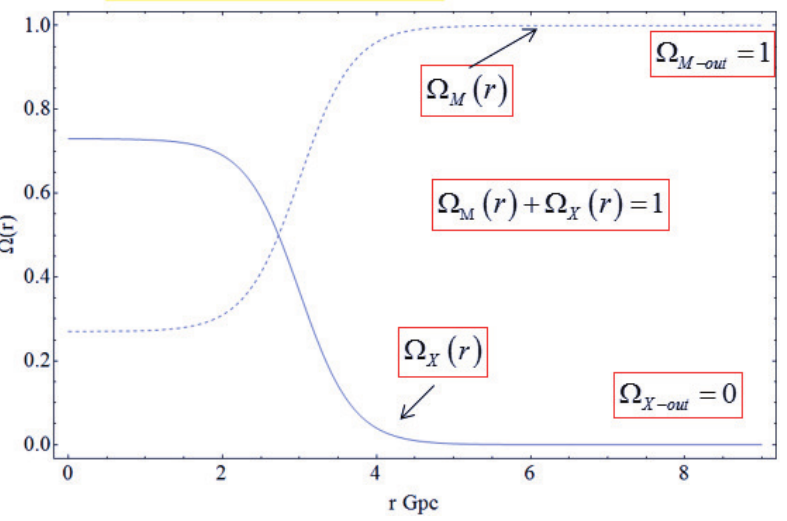
Figure 9. The assumed matter and dark energy profiles are consistent with flatness and with matter domination outside the inhomogeneity. Such profiles would develop dynamically in the context of topological quintessence (see Figure